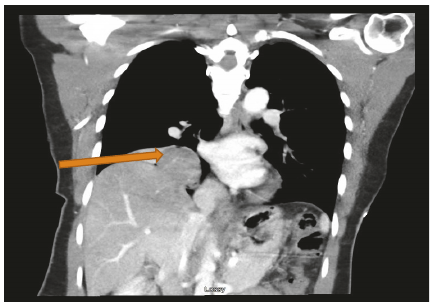
Figure 1: The blue arrows show the visceral pleural line indicating the presence of pneumothorax and diaphragmatic free air. The orange arrow reveals a large 56 mm mass at the base of the lung (confirmed as liver on computed tomography).